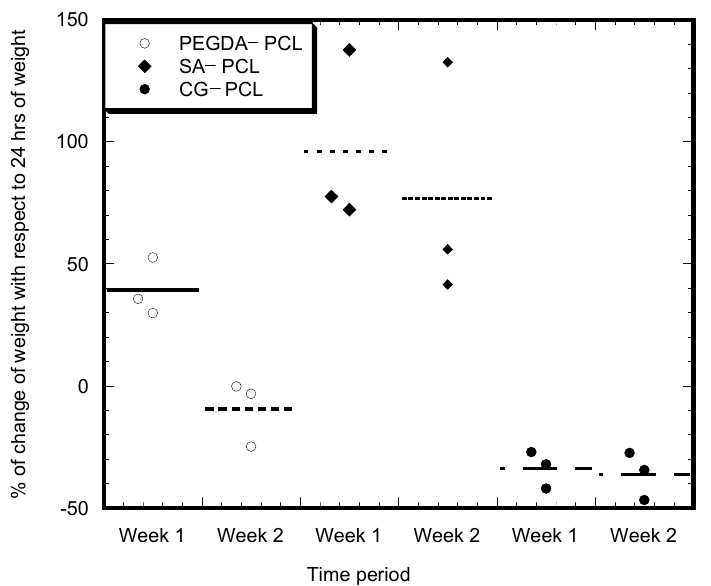
Figure 10. Percentage of weight change plots of the PEGDA-PCL, SA-PCL, and CG1-PCL specimens with respect to 7 and 14 days swelling in PBS. The values of the weights were normalized with respect to weights of the samples after swelling the samples for 24 h. Data are presented with n = 3 for all samples.